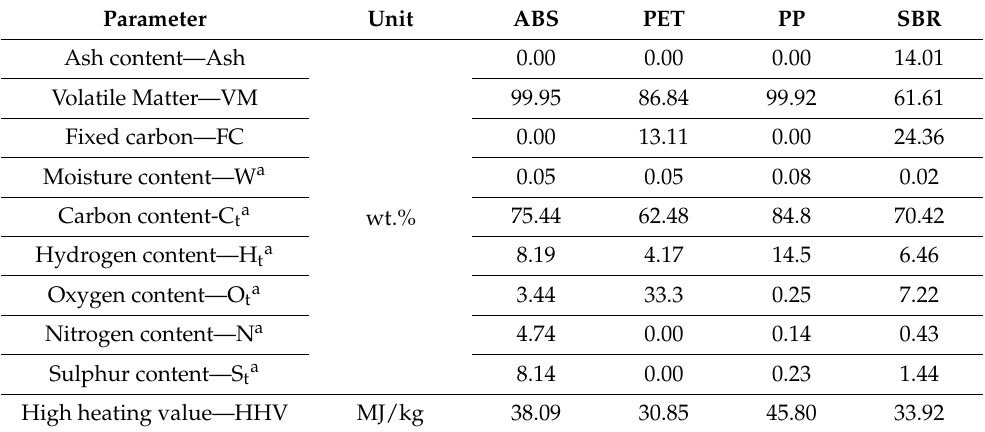
Table 1. Basic physical and chemical characterisation of waste polymers [37], reproduced with permission from